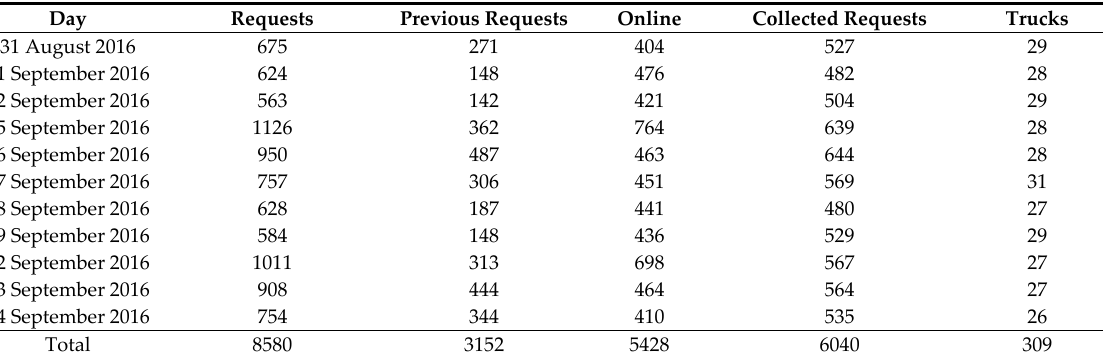
Table A1. Results obtained by the company.